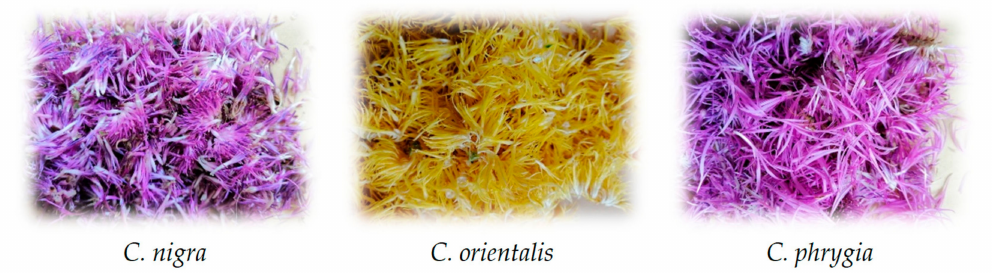
Figure 3. Visual appearance of three Centaurea species